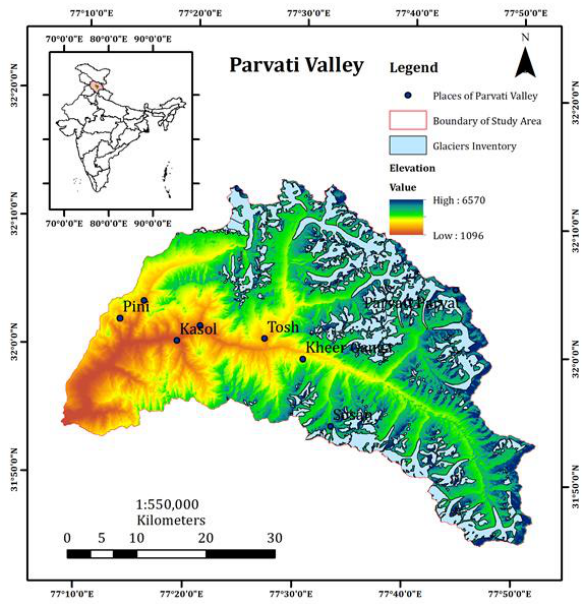
Figure 1: The Map of the study area shown on the digital elevation model (DEM) data by Shuttle Radar Topographic Mission (SRTM) showing the glacier extents according by GLIMS